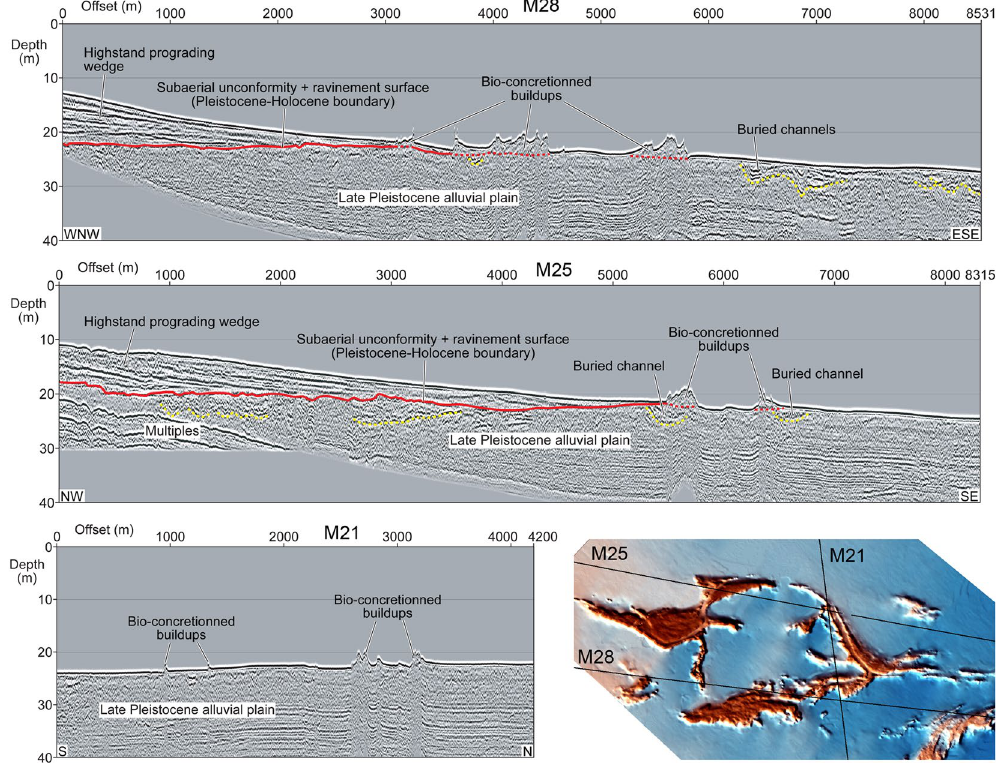
Figure 3. ( A , B , C ) Examples of High-resolution seismic surveys crossing the tegnùe field. Yellow and red lines highlight major channelized features and the contact between Holocene and Pleistocene seismic units, respectively. The inset shows the seismic line positions superposed to the swath bathymetry shaded relief map. Seismic images obtained by IHS Kingdom ® software educational licence (https://www.ihs.com/products/ educational-grant.html) and edited with Gimp 2.8.14.1